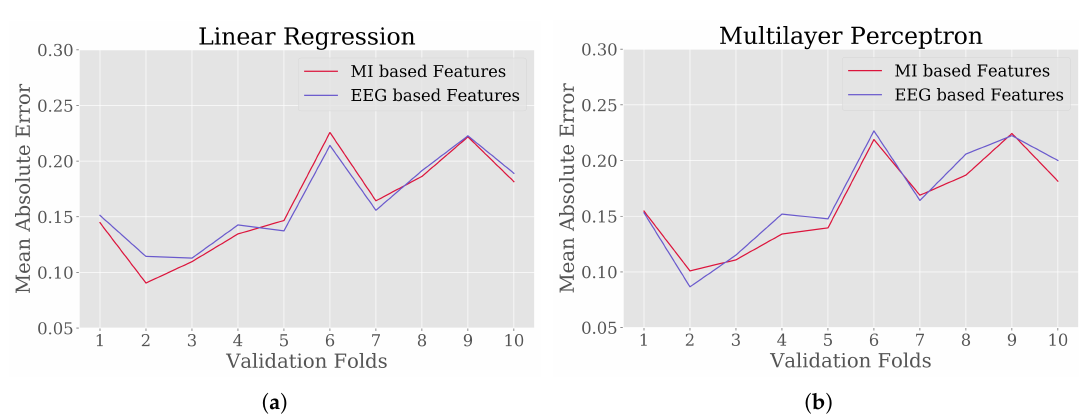
Figure 6. The 10-fold Cross Validation (CV) score in terms of Mean Absolute Error (MAE) for regression models: ( a ) Linear Regression (LnR) and ( b ) Multilayer Perceptron (MLP), where the expert derived MWL scores were considered as true values. For each of the models, two different sets of features were used (Table 2).